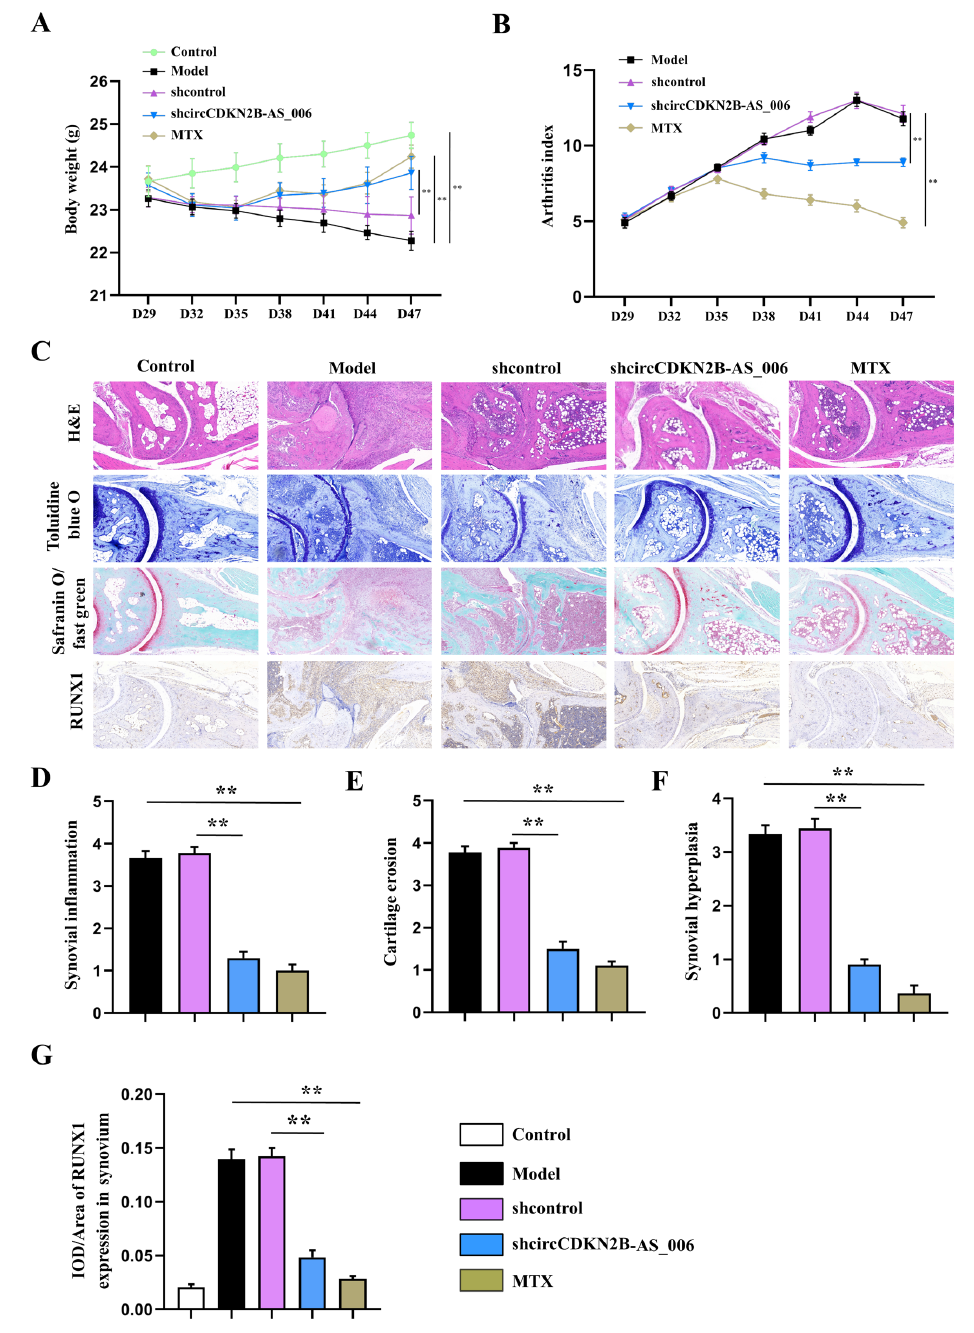
Figure 8. Local knockdown of circCDKN2B − AS_006 attenuated the severity of CIA in mice. ( A ) Effects of sh − circCDKN2B − AS_006 on the body weight of CIA mice. ( B ) Effects of sh − circCDKN2B − AS_006 on the polyarthritis index of CIA mice. ( C ) Representative micrographs of HE - , toluidine blue−, and safranin O/fast green−stained histological sections and immunostaining of RUNX1 and β−catenin of the joints. ( D ) Quantification of the histomorphometric analysis of synovial inflammation. ( E ) Quantification of the histomorphometric analysis of cartilage damage. ( F ) Quantification of the histomorphometric analysis of bone erosion. ( G ) Quantitative analysis of the immunohistochemical detection of RUNX1 expression in synovia. ** p < 0.01 compared to the shcontrol group ( n = 9–10 per